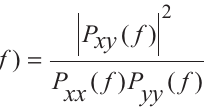
Figure 2. Movement detection based on signal processing. A : signal processing of an accelerometer; B : of a gyroscope; and C : of a magnetometer (triaxial sensors: axis x, y, and z). The dotted line corresponds to a voluntary movement. Three time intervals were studied: pre-movement period, movement period, post-movement period. The pre-movement period (lasting 2 seconds) was defined according to the acoustic order given to the patients and the detection of the beginning of movement via the gyroscopes, by considering 2 seconds back from the point of detec- tion of the beginning of movement. We decided to use a period of 2000 msec based on the available literature which considers that 2 seconds encompasses the preparation phase at the cortical level 13 . The α , β and γ frequency bands were compared by calculating β / α and β ²/ α ratios. PSD in a β - γ frequency band was divided by the PSD in the α frequency